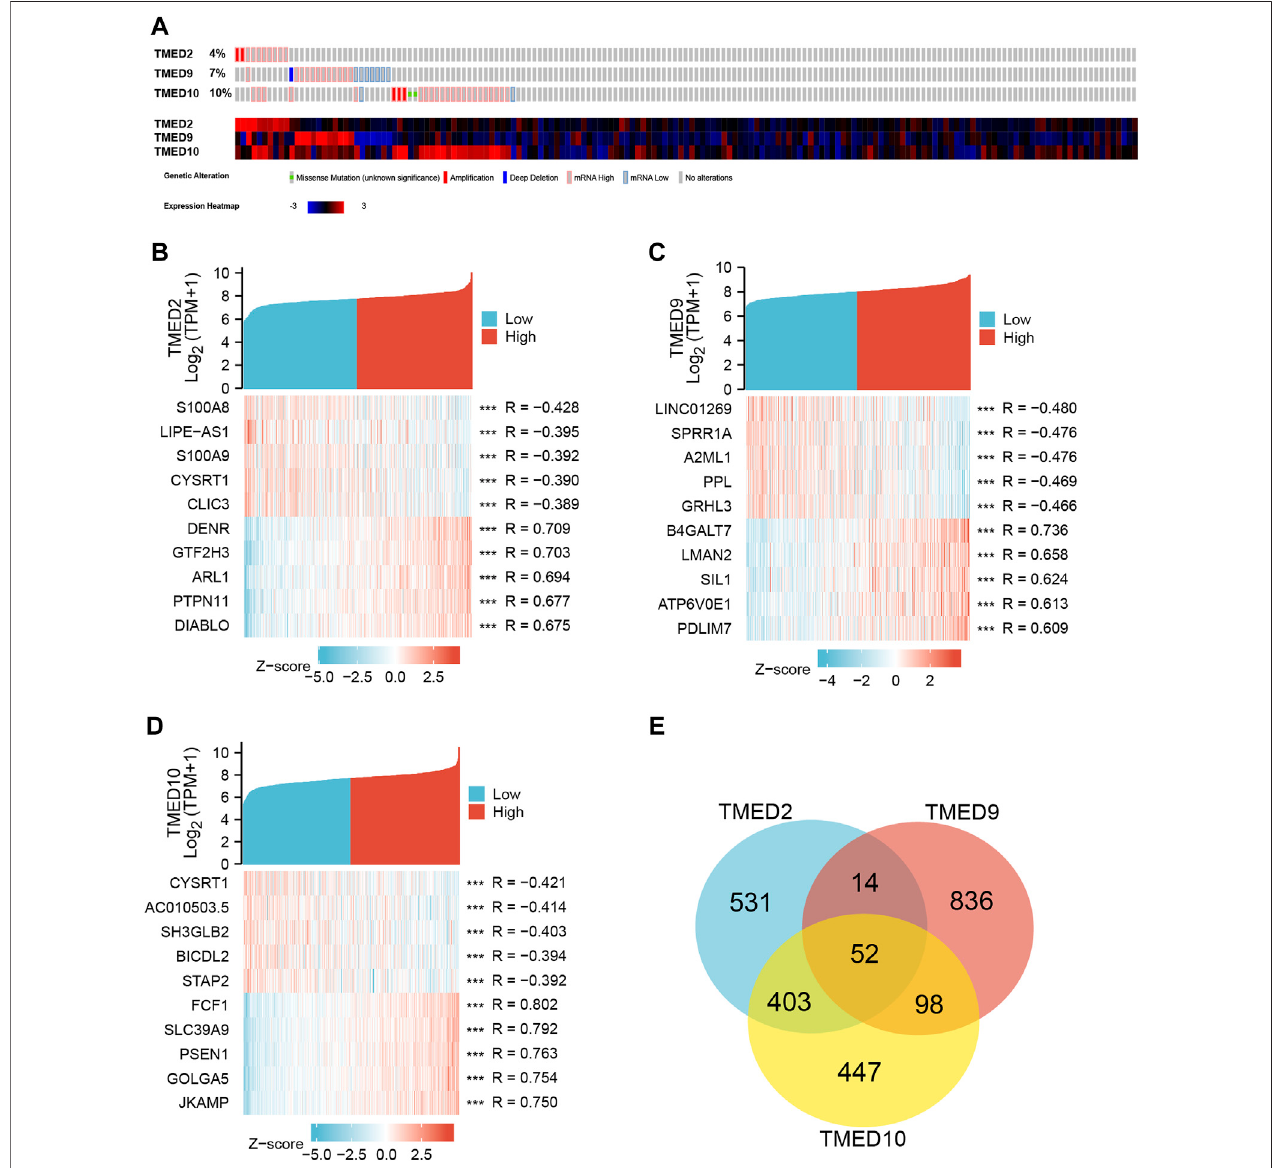
FIGURE5|(A) ExpressionlevelsofTMED2/9/10 incBioPortaldatabase inHNSC. (B – D) Heatmap analysisofgenesassociatedwithTMED2/9/10 expression. (E) Intersection co-expression genes of TMED2/9/10.